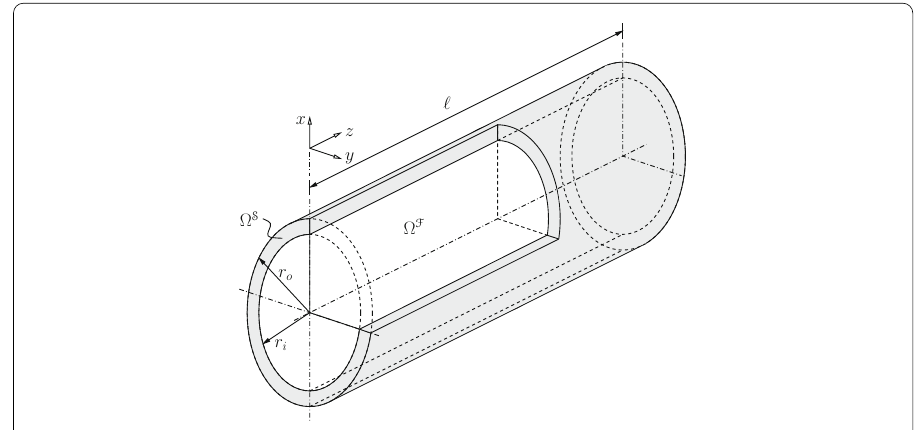
Fig. 3 Geometry of pressure wave through an elastic tube—a solid tube (outer radius r o = 0 . 6cm, inner radius r i = 0 . 5cm, length (cid:8) = 5 . 0cm) is clamped at both ends and is filled with an incompressible Newtonian fluid that is initially at